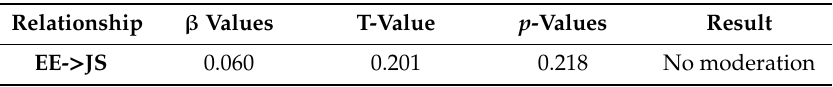
Table 6. Results of moderation analysis of SS on the relationships between